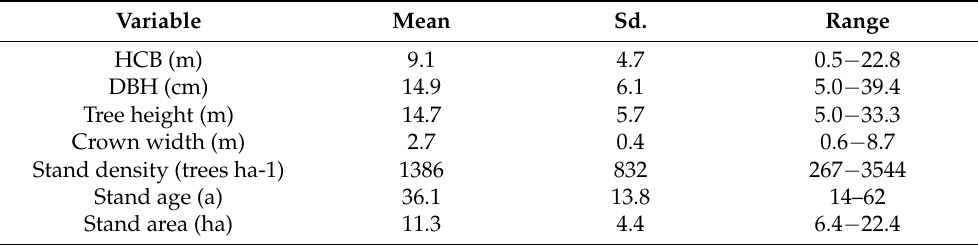
Figure 1. Location of the study site: Mengjiagang Forest farm in northeast China. Table 1. Descriptive statistics of the field-measured